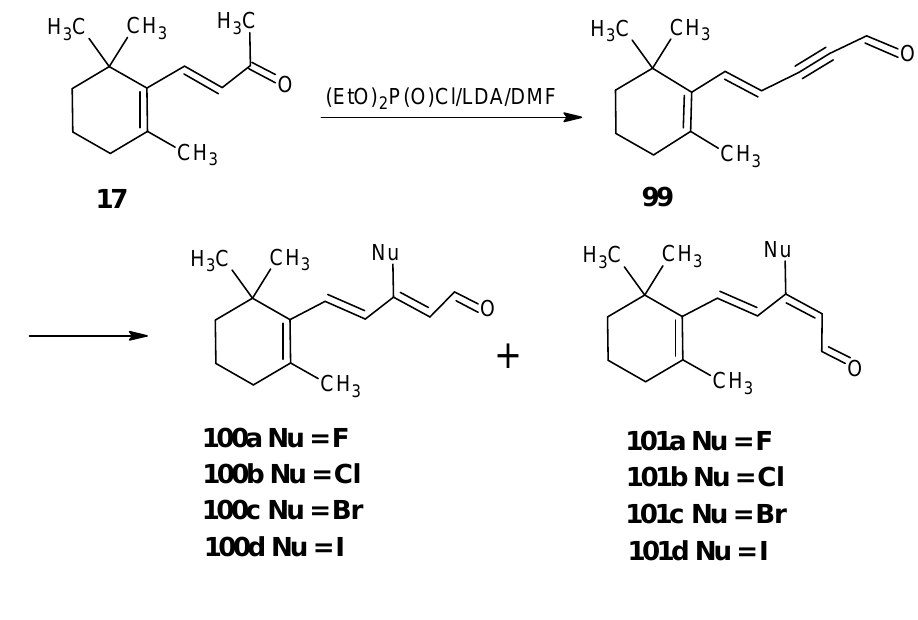
Scheme 23. Preparation of (9 Z )- 9-halo- β -ionylidene acetaldehyde 100a , 100b , 100c , 100d and their all- E isomers 101a , 101b , 101c , 101d